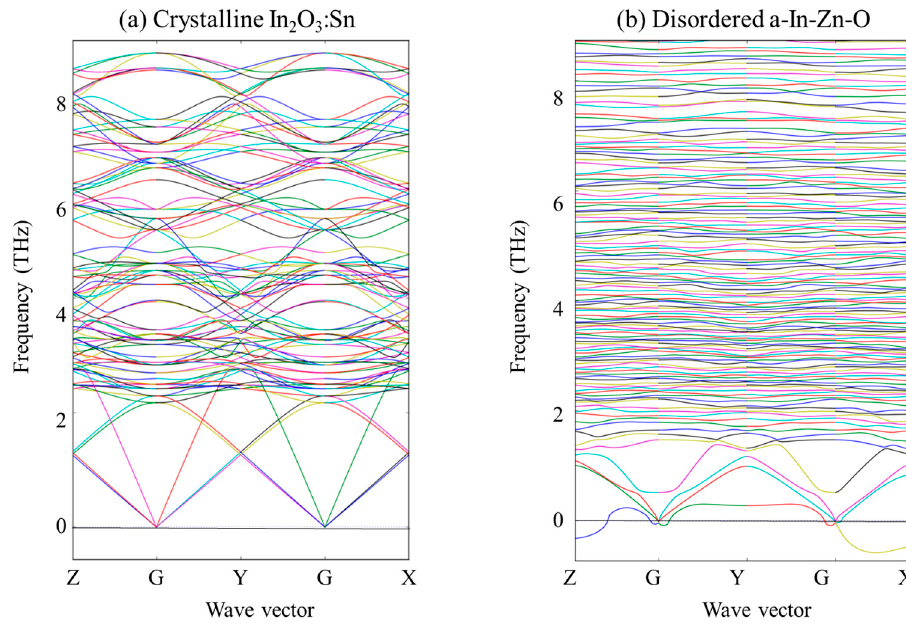
Figure 4. Calculated dispersion relations of phonon states by the first-principles calculation are compared between ( a ) crystalline In 55 Sn 9 O 96 and ( b ) disordered amorphous In 54 Zn 8 O 88 generated by the ab-initio molecular dynamics simulation. Here, Z , Y , X , and G are (0,0,1/2), (0,1/2,0), (1/2,0,0), and (0,0,0) points in the Brillouin zone, respectively.